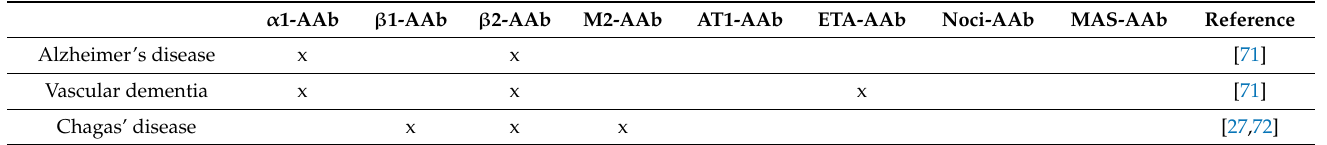
Table 4. Seropositivity of GPCR-AAbs in local and systemic